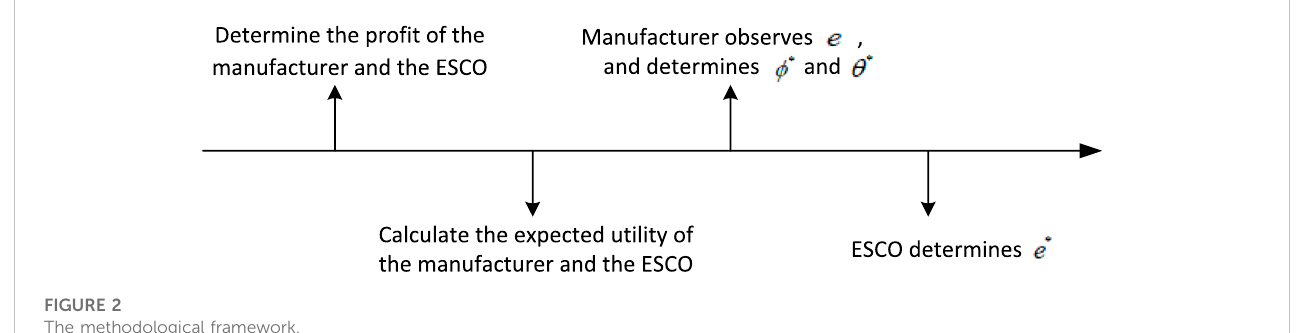
FIGURE 2 The methodological